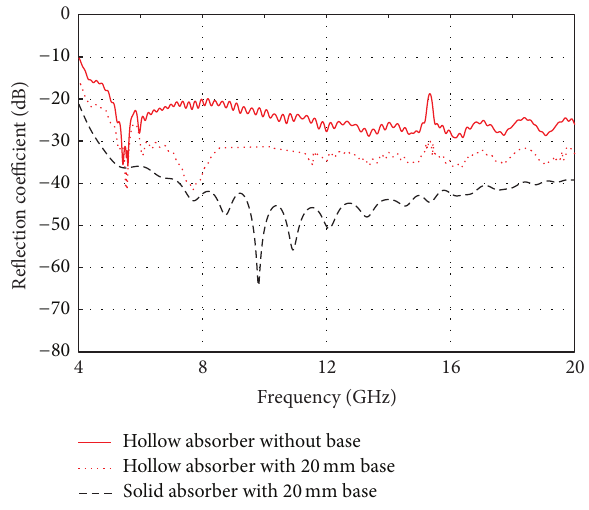
Figure6:Reflectioncoefficientasafunctionoffrequencyfor10 mm thick-walled hollow (with and without base part) and a solid pyra- midal absorber.